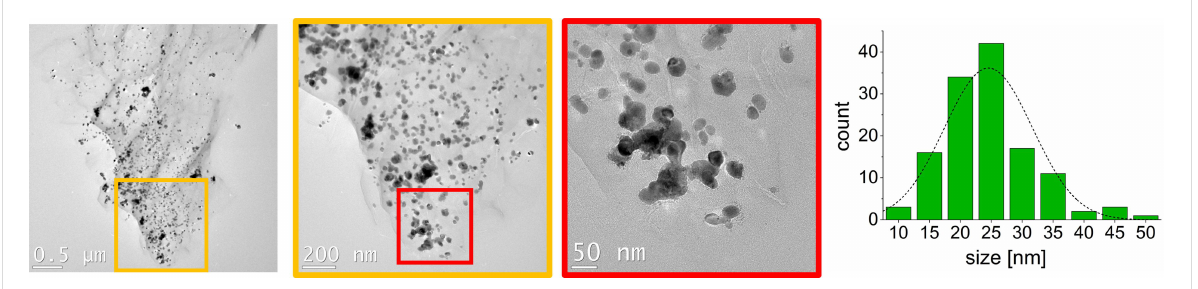
Figure 2: TEM images of Ni@rGO obtained from a 0.5 wt % dispersion of Ni(COD) 2 in [BMIm][NTf 2 ]. Particle size 25 ± 5 nm.